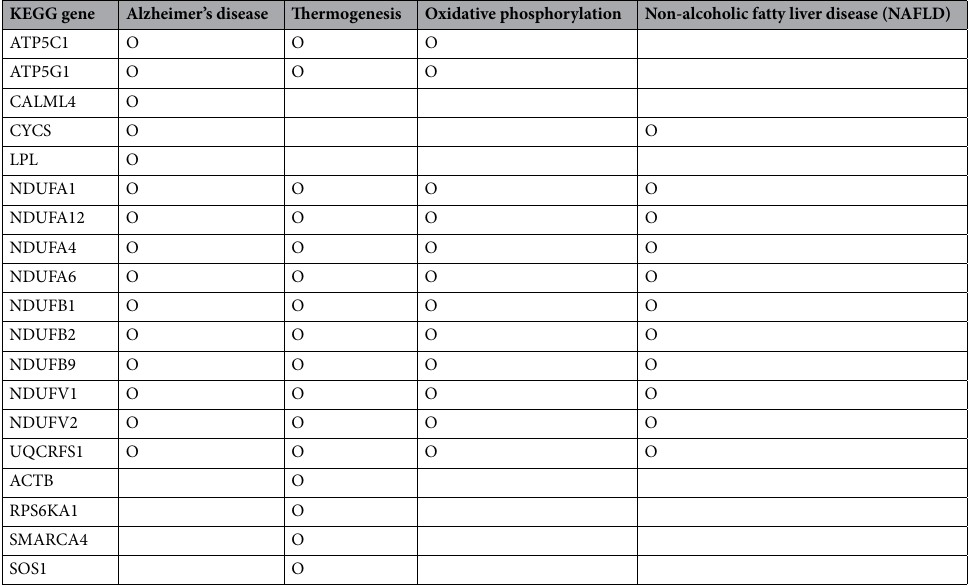
Table 2. Overlapping of ML-identified genes in the enriched KEGG pathways. “O” denotes the presence of the